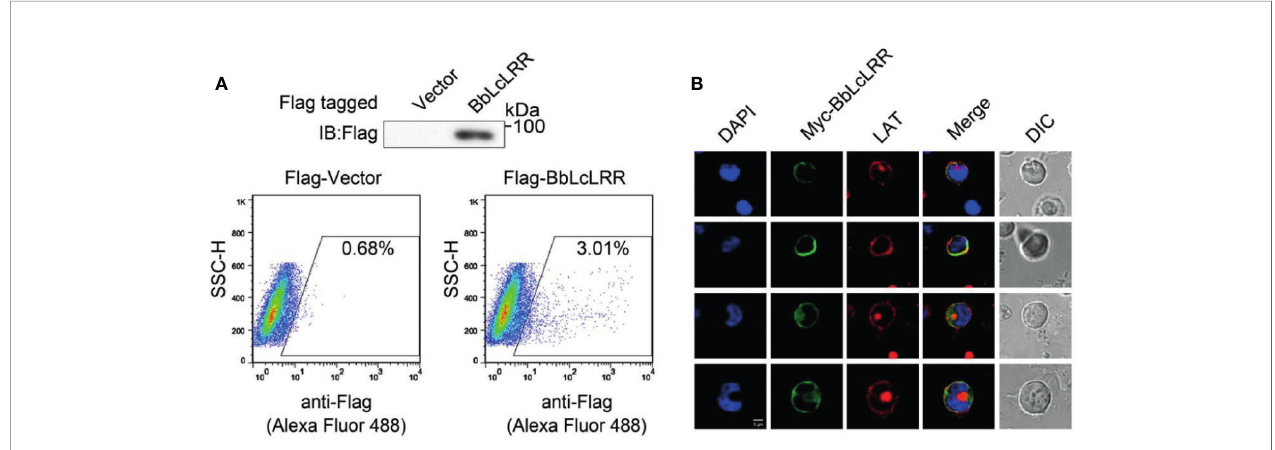
FIGURE 4 | Membrane localization of BbLcLRR. (A) The Flag-BbLcLRR was identi fi ed by fl ow cytometry. Flag-BbLcLRR was overexpressed in HEK293T cells and stained with anti-Flag antibody followed by fl uorophore-conjugated secondary antibody without cell membrane permeation treatment. (B) Cell membrane colocalization of overexpressed Myc-BbLcLRR (green) and endogenous LAT (red) in Jurkat TAg T cells. Nuclei were stained blue. Scale bar,5 m m. Data are representatives at least three independent